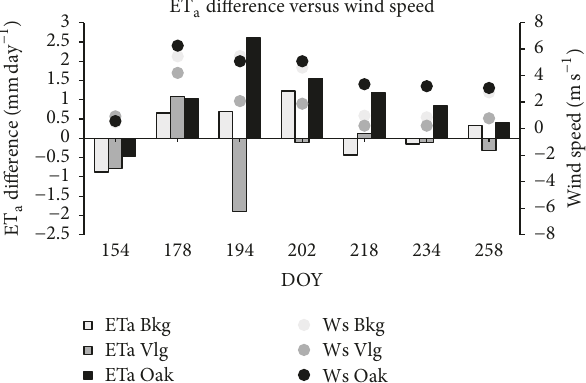
Figure 11: Comparison between average ET eastern South Dakota. The columns indicate ET